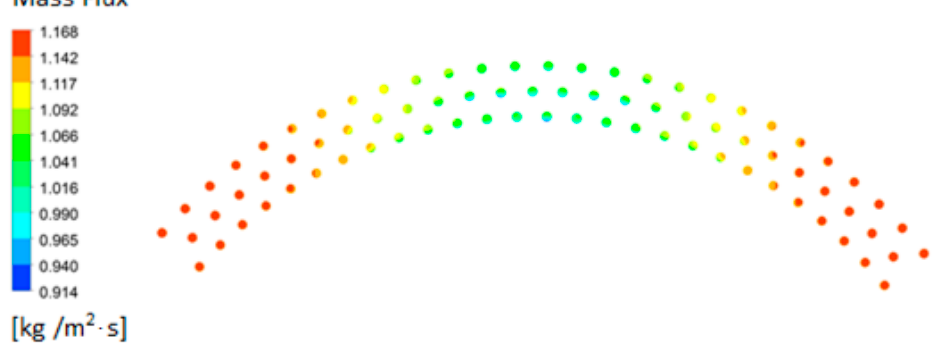
Figure 13. Carrier gas (nitrogen) mass flux distribution over the 80 tubes of the solar reactor.